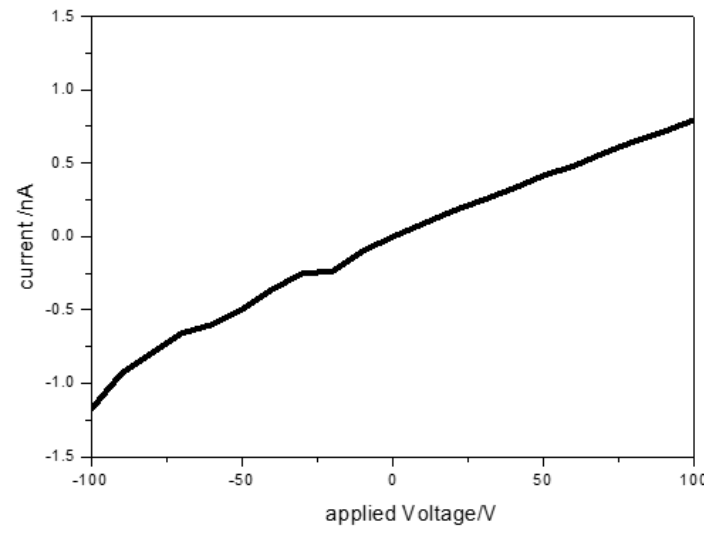
Figure 4. I–V characteristic of polyscrystalline HgI 2 film.